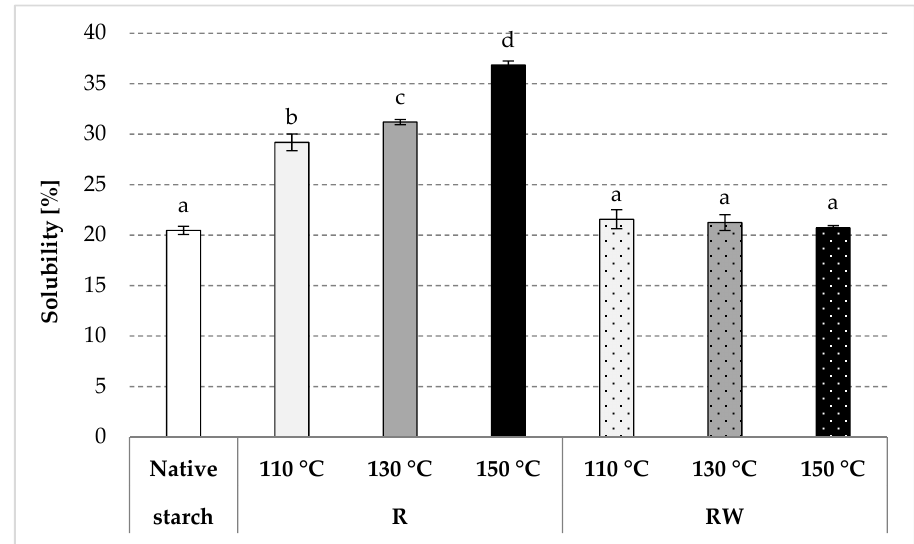
Figure 3. Solubility in water determined in the native and modified starch preparations. The results are expressed as the mean ± SD ( n = 3). Different letters above the bars indicate that the values are significantly different at p < 0.05. R—roasted starch without wastewater; RW—roasted starch with wastewater.